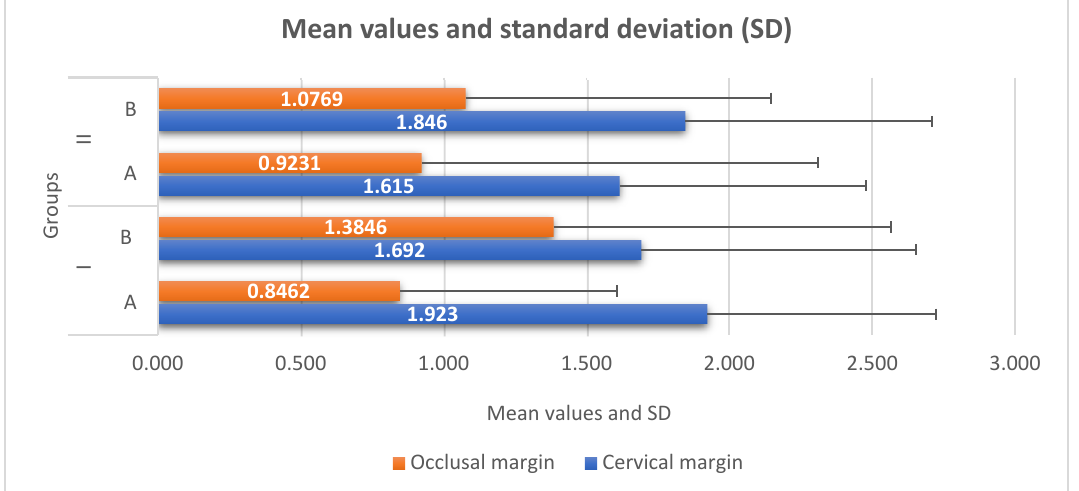
Figure 2. Mean values and standard deviation at occlusal/cervical margin for each group. IA—etch-and-rinse technique (adhesive only); IB—etch-and-rinse technique (2% clorhexidine solution pre-treatment); IIA—self-etch technique (adhesive only); IIB—self-etch technique (2% chlorhexidine solution pre-treatment).